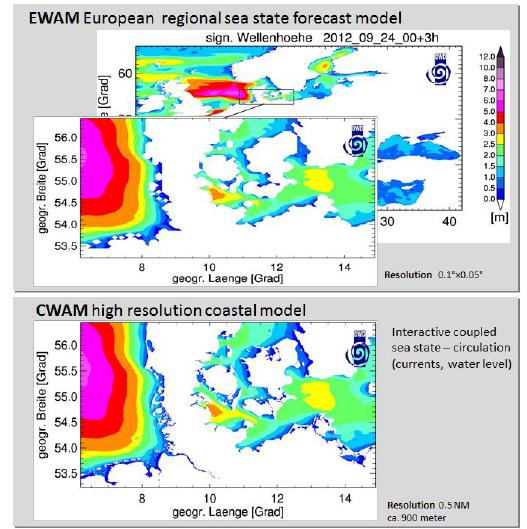
Figure 1. Conventional EWAM sea state forecast and new high resolution coastal model CWAM (0.5NM=~900m). Local differences of resulting H S in coastal areas are in the range of meters because of more structures in bathymetry (1) and rapid change of water level and circulation currents by tides not resolved by EWAM in intertidal Watt zone